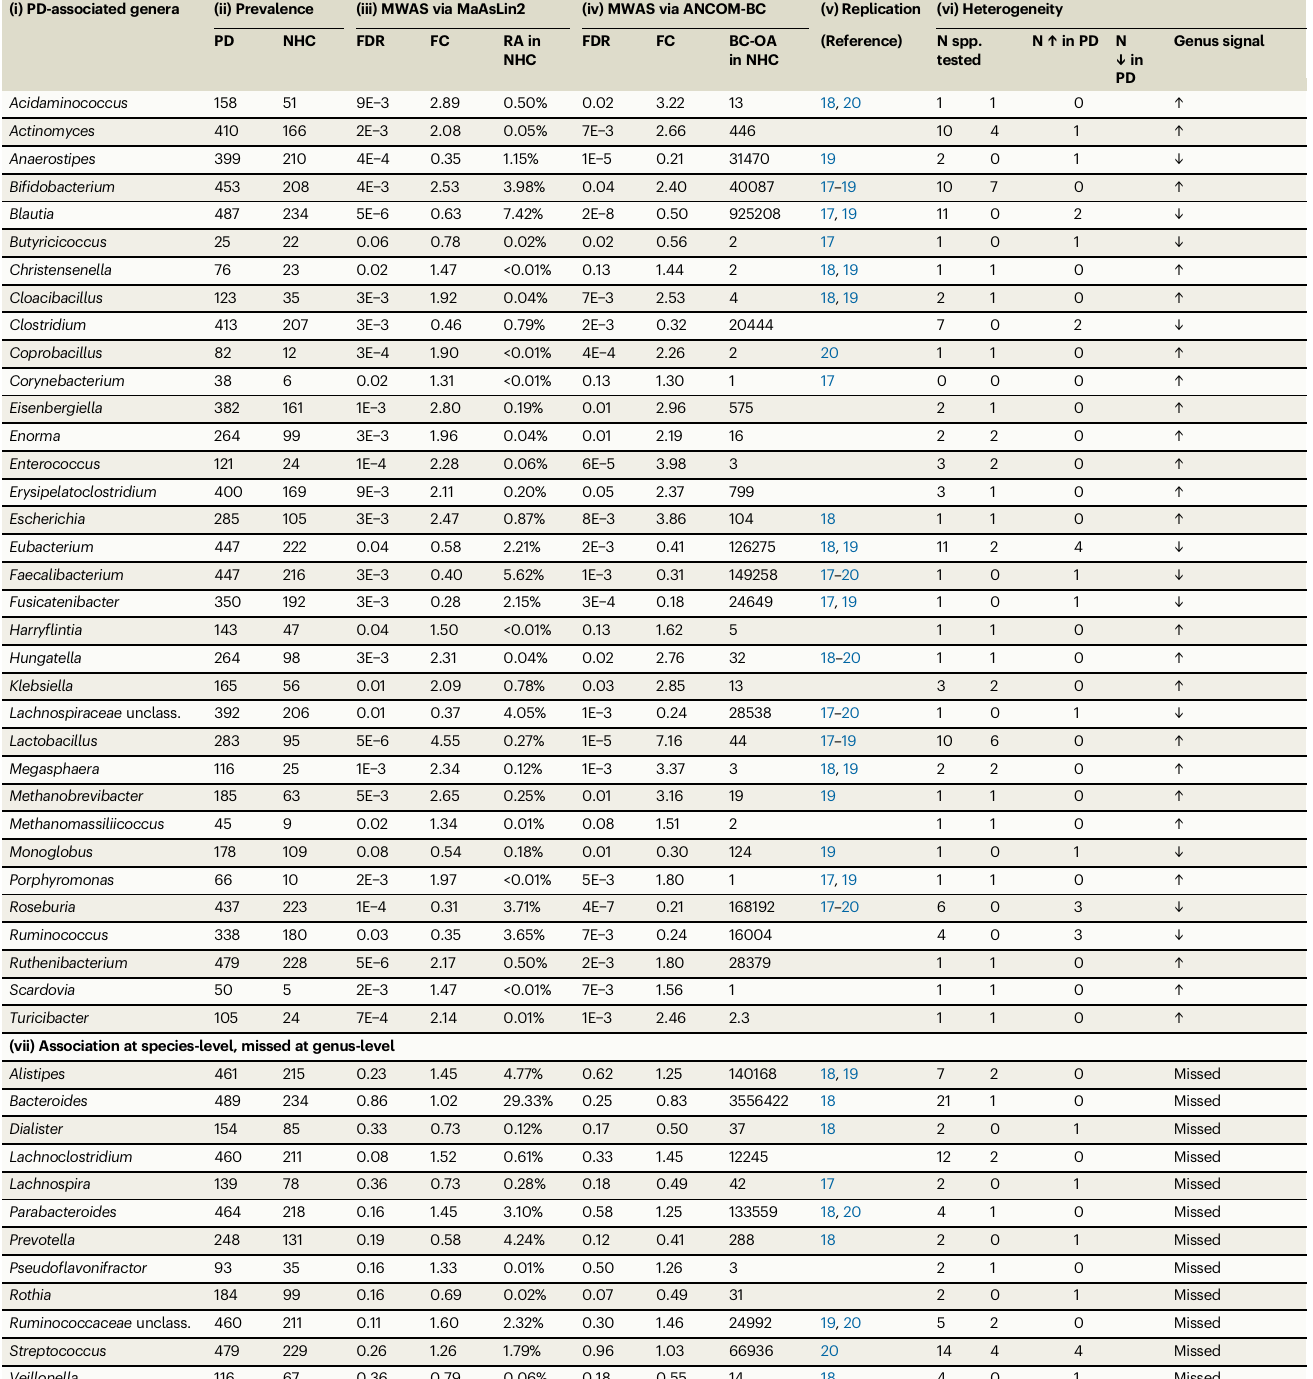
Table 3 | PD-associated genera, replication of prior fi ndings, and evidence of heterogeneity (i)PD-associated